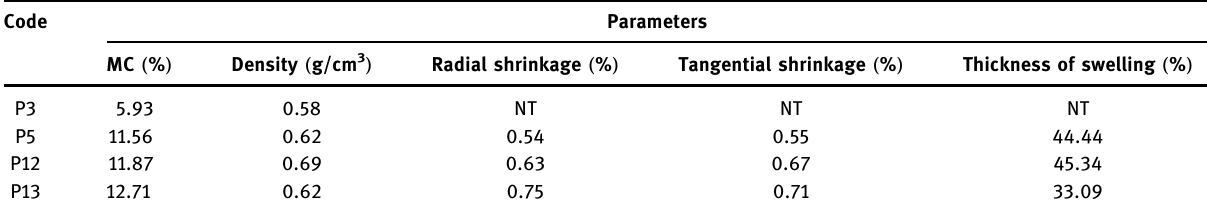
Table 3: Physical properties of particleboards Code